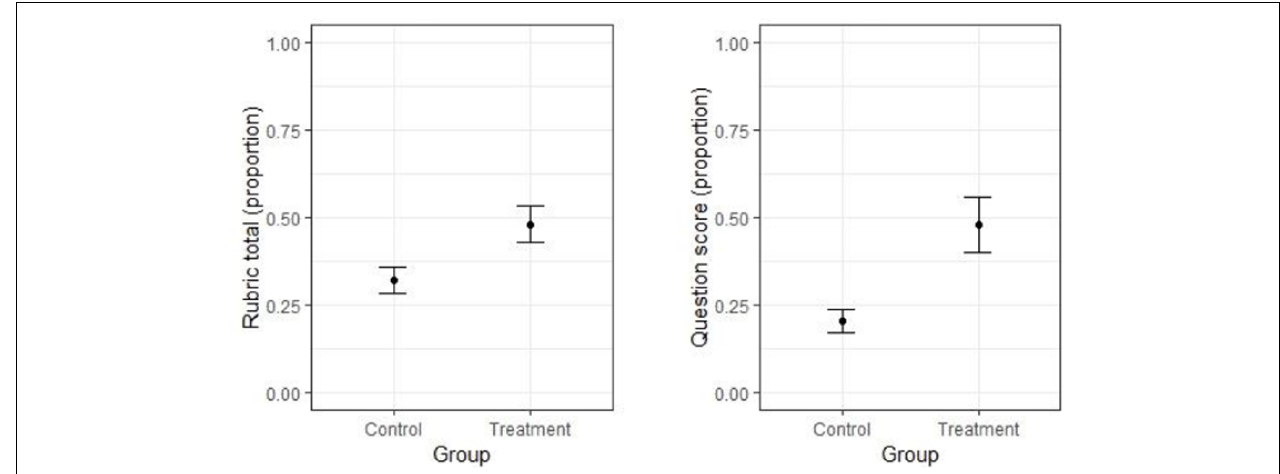
FIGURE 2 | Left panel: Means (and their 95% CIs) for the two groups on the total rubric score. Right panel: Means (and their 95% CIs) for the two groups on the explicit problem